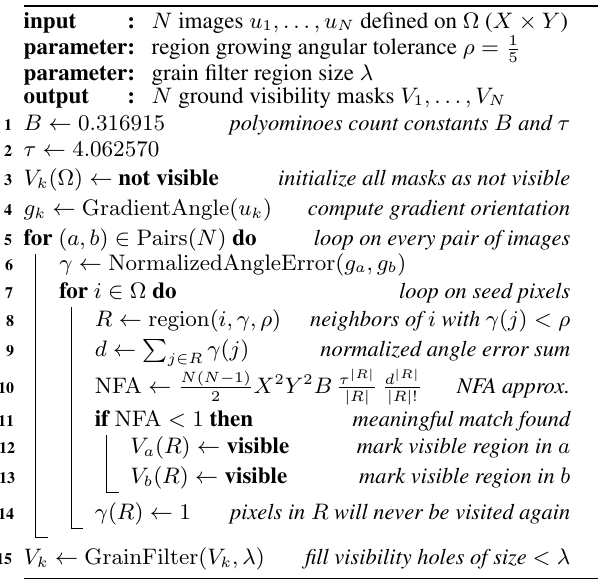
Algorithm 1: Ground visibility detection